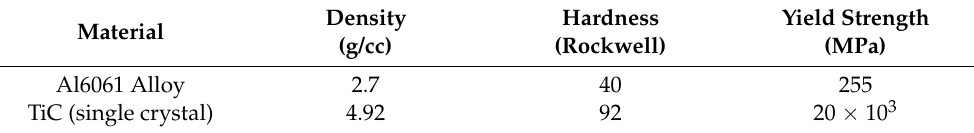
Table 2. Al6061 and TiC particle reinforcement